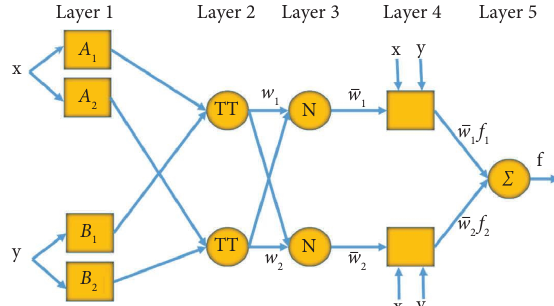
Figure 1: Equivalent ANFIS structure. (adapted from [22, 32,